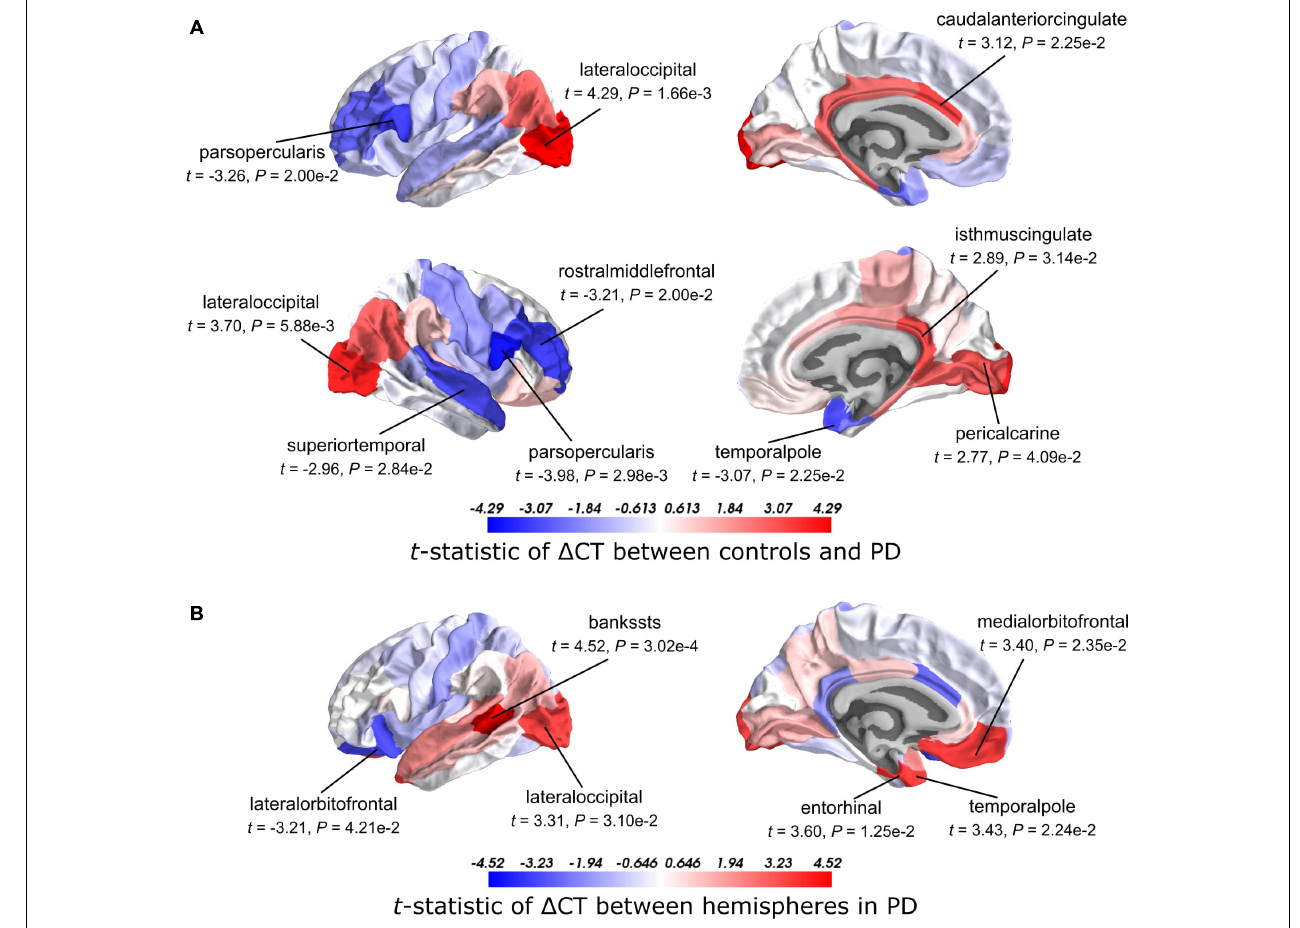
FIGURE 2 | t -Statistics of cortical thickness changes ( (cid:49) CT) across cortical regions. (A) CT was assessed between PD patients and healthy controls. Higher t -statistics (red) indicate a larger CT in controls compared to the CT in patients and thus corresponds to cortical atrophy. (B) CT in the left hemisphere compared to the right hemisphere in PD patients. Higher t -statistics (red) indicate a larger CT in the right hemisphere compared to the left hemisphere and thus corresponds to cortical atrophy in the left hemisphere. P -values are BH-corrected and significant regions ( P < 0.05) are